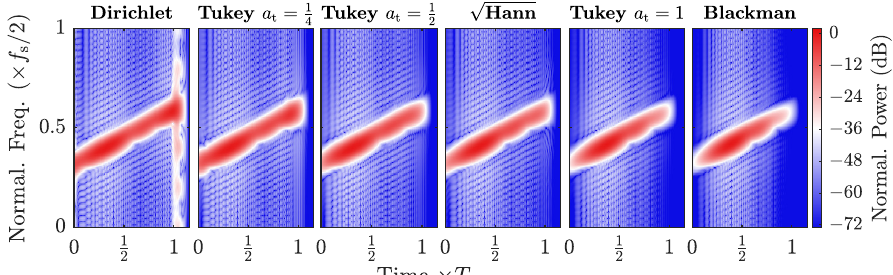
Figure 5. Simulated spectrograms of the autocorrelations of a selection of shaping window functions. All magnitudes are normalized by the Dirichlet shaped chirp power for comparison. Gaussian noise was added to a signal-to-noise ratio of 0dB, as well as two echoes at n = 9 and n =